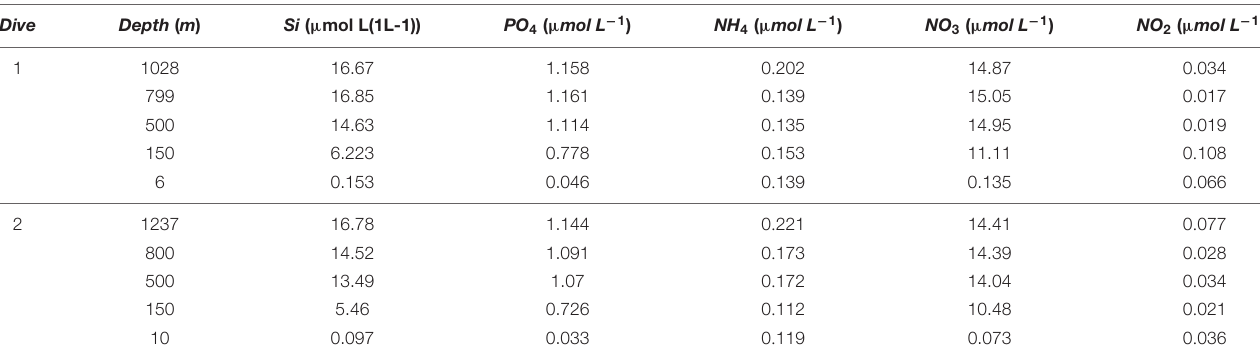
TABLE 1 | Concentration of nutrients over depth for Dive 1 (central) and Dive 2 (near-sill) in Sognefjord,